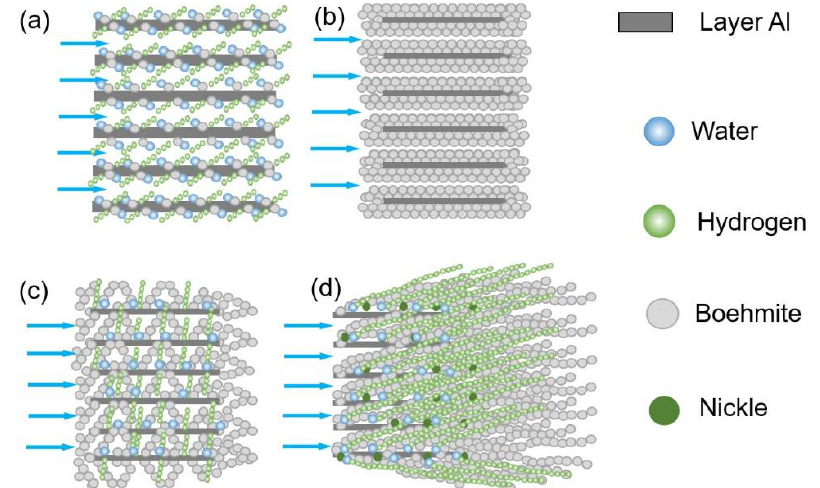
Figure 11. Reaction process for Al-LMP alloys under different conditions. ( a ) Layered Al reacted with water, ( b ) plates and powders, ( c ) ball-milling powders, ( d ) ball-milling powder with NiCl 2 .